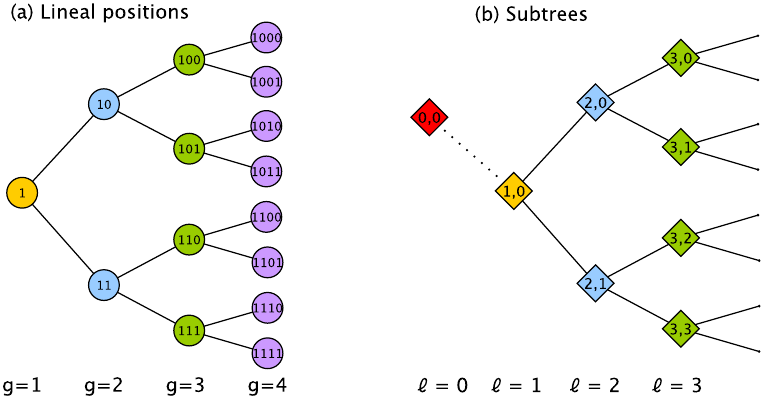
Fig 3. Labeling convention for a lineage tree. (a) Each lineal position is labeled with a binary number. The founder of the tree is located at generation g = 1. (b) Each subtree is labeled with two indices ( ℓ , τ ) representing the longitudinal ( ℓ ) and transverse ( τ ) coordinates of its root. Because, as we discuss later, roots of subtrees are associated with sources of variation we need to create a ‘subtree’ located outside the lineage, called (0, 0) (in red), to represent variation among pedigrees. Note that, in an unordered tree, τ values are unidentifiable and will often be